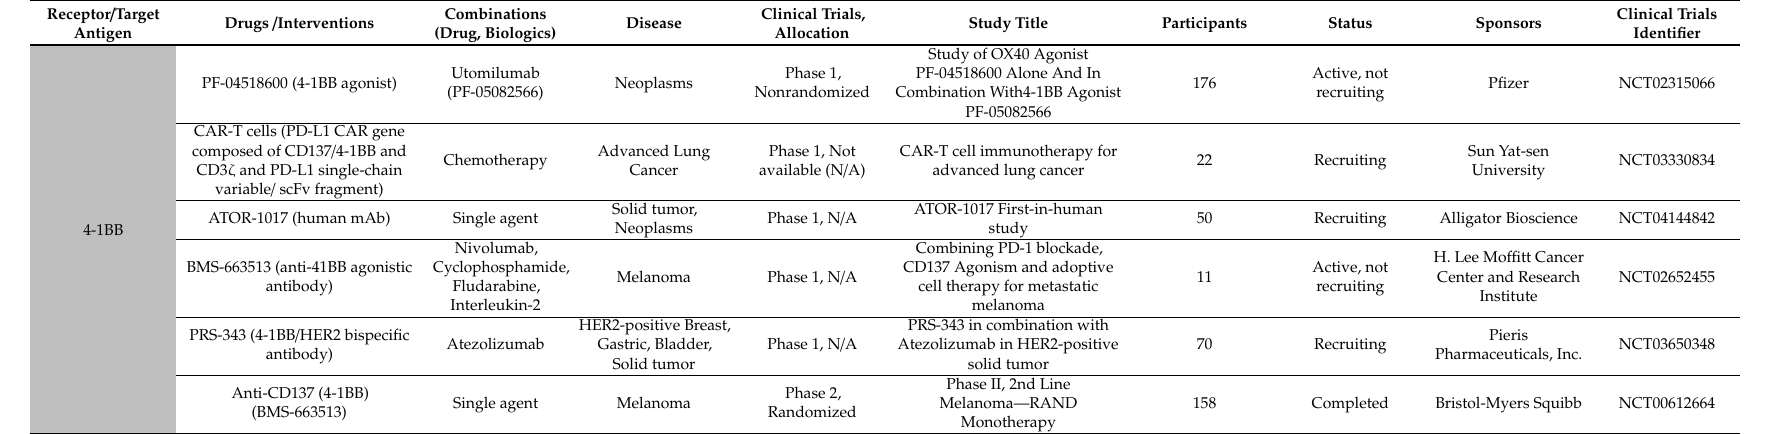
Table 1. Clinical trials combining checkpoint receptor based targeting with or without